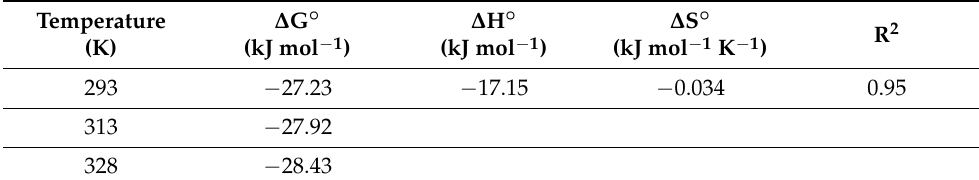
Figure 10. ( a ) Van’t Hoff plot and ( b ) reusability test of AC@PIN composite. Table 3. Calculated values of thermodynamic